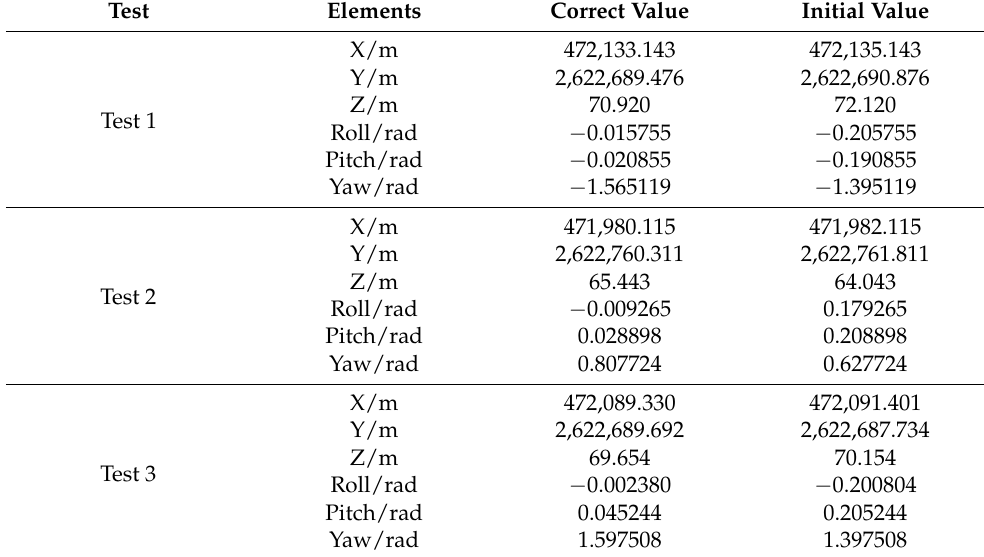
Table 7. Experimental data of external orientation parameters: the (Initial value) column represents the initial value of the element, and the (Correct value) column represents the correct value of the element. Test Elements Correct Value Initial Value X/m Test 1